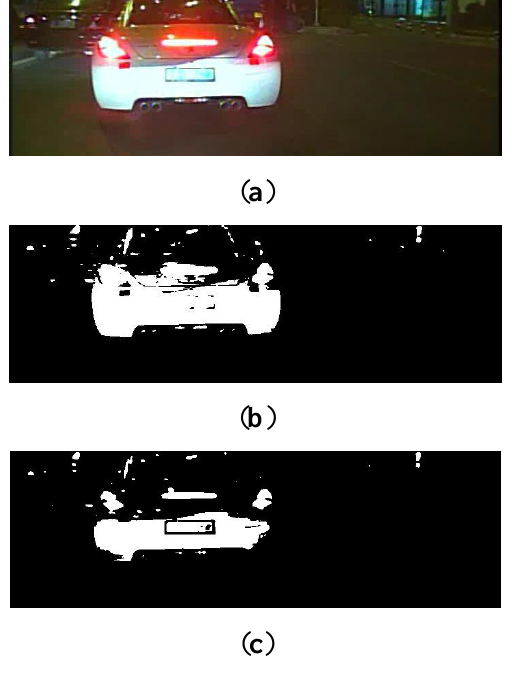
Figure 3. Result of taillights segmentation: ( a ) Original image; ( b ) Result of taillights segmentation by the common OTSU method; ( c ) Result of taillights segmentation by the proposed